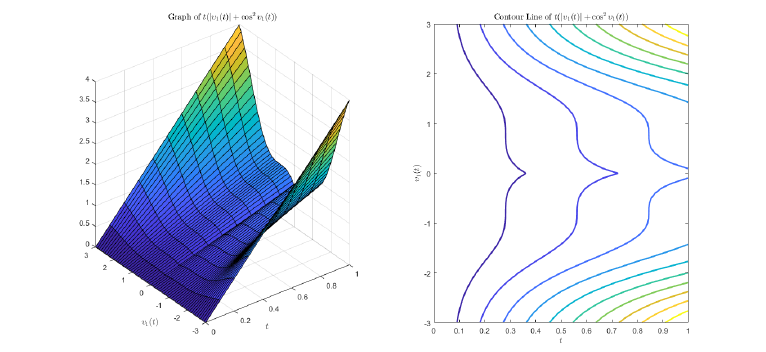
Figure 1. The graph of t ( | υ 1 ( t ) | + cos 2 υ 1 ( t )) .